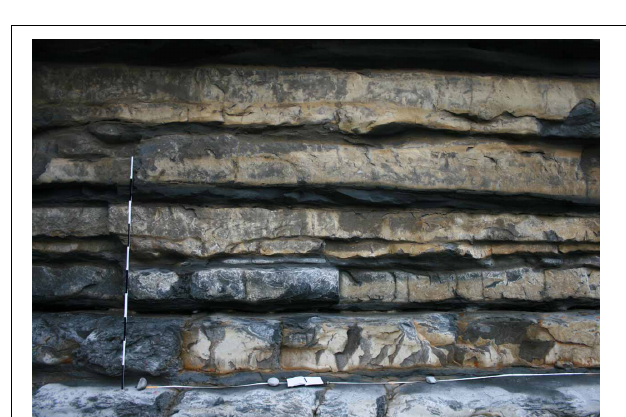
FIGURE 7 | In mechanically layered rocks, such as this succession of limestone and shale at Nash Point, Glamorgan coast, South Wales, many fractures, such as these joints, become restricted to certain layers. The joints presumably became arrested when their tips tried to propagate from the stiffer limestone layers into the much softer shale layers. Arrested fractures contribute significantly less to the overall permeability of a fluid reservoir than do fractures that propagate through many layers, since they are less likely to develop interconnected fracture systems that reach the percolation threshold. View east; the measuring steel tape is 2m